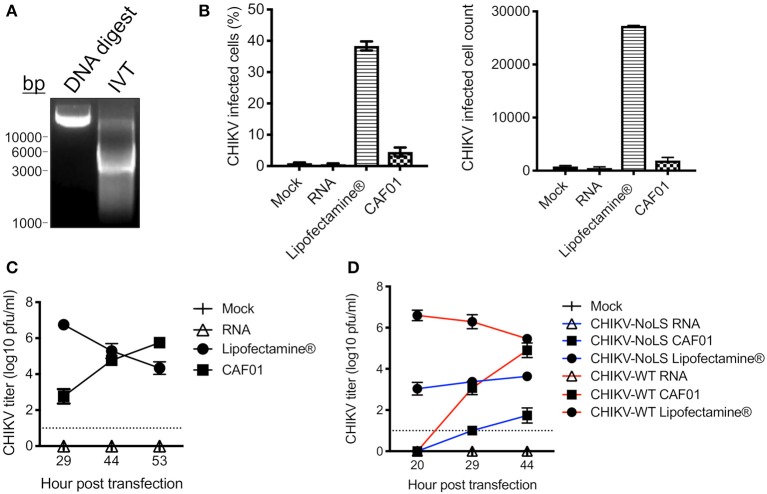
CAF01 RNA formulation and in vitro assays. (A) CHIKV-WT linearized DNA infectious clone (DNA digest) and in vitro transcribed CHIKV-WT RNA (IVT) were run on a 1% agarose gel and visualized using GelRed® under UV light. (B) CHIKV-WT RNA was transfected into Vero cells using either Lipofectamine® or CAF01. Cells were also mock transfected or transfected with RNA alone. At 12 h post transfection, infectivity (percentage and cell count) was measured by flow cytometry. (C) From 29 h post transfection, CHIKV-WT growth kinetics were analyzed by plaque assay. (D) CHIKV-WT and CHIKV-NoLS RNA was transfected into Vero cells using either Lipofectamine® or CAF01. Cells were also mock transfected or transfected with RNA alone. Viral growth kinetics were analyzed by plaque assay. Each symbol represents the mean ± standard error from three independent experiments.